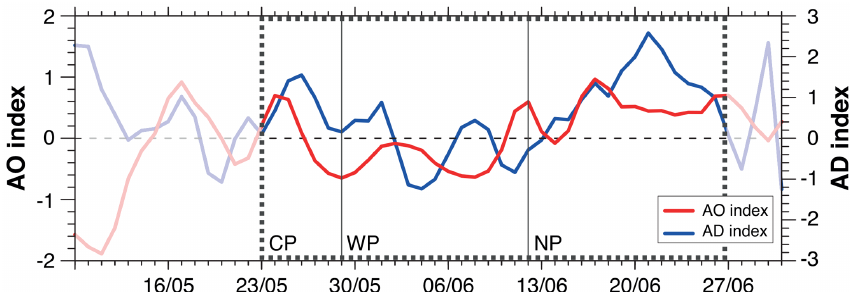
Figure A2. Time series of daily Arctic oscillation (AO) and Arctic dipole (AD) indices over the ACLOUD/PASCAL extended period (9 May– 1 July 2017), based on ERA-I data. Dotted boxes indicate the ACLOUD/PASCAL measurement period (23 May–26 June), while vertical lines separate the three key periods (CP, WP, and NP) defined in Sect.